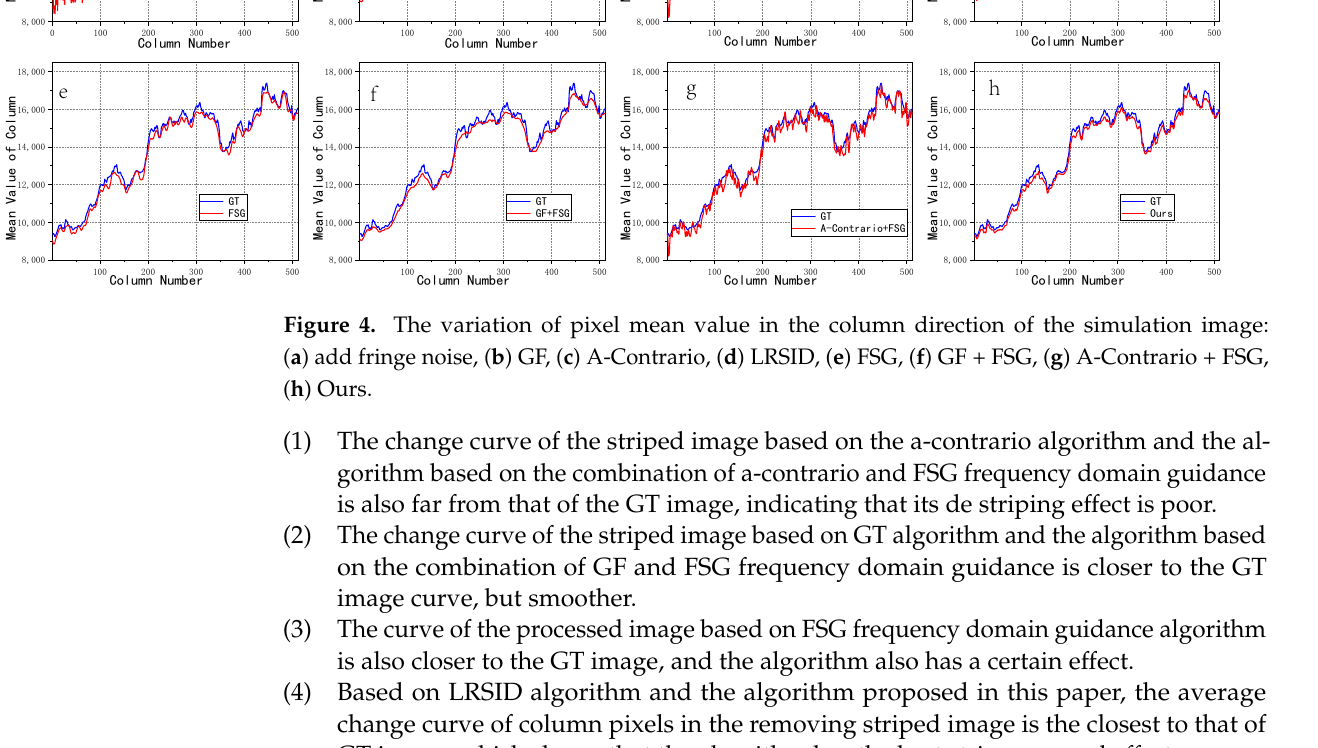
GT image, which shows that the algorithm has the best strips removal effect.